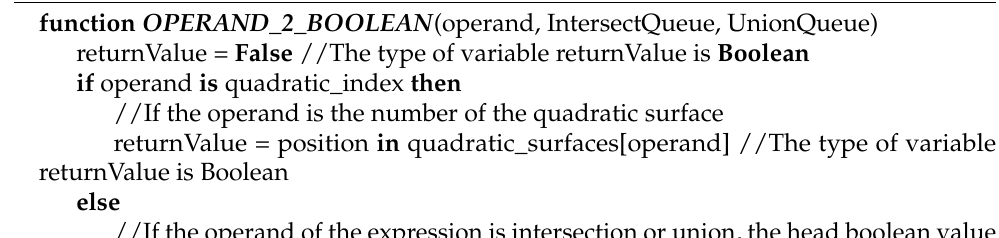
Algorithm 1 QUADRATIC_SURFACE_QUERY()